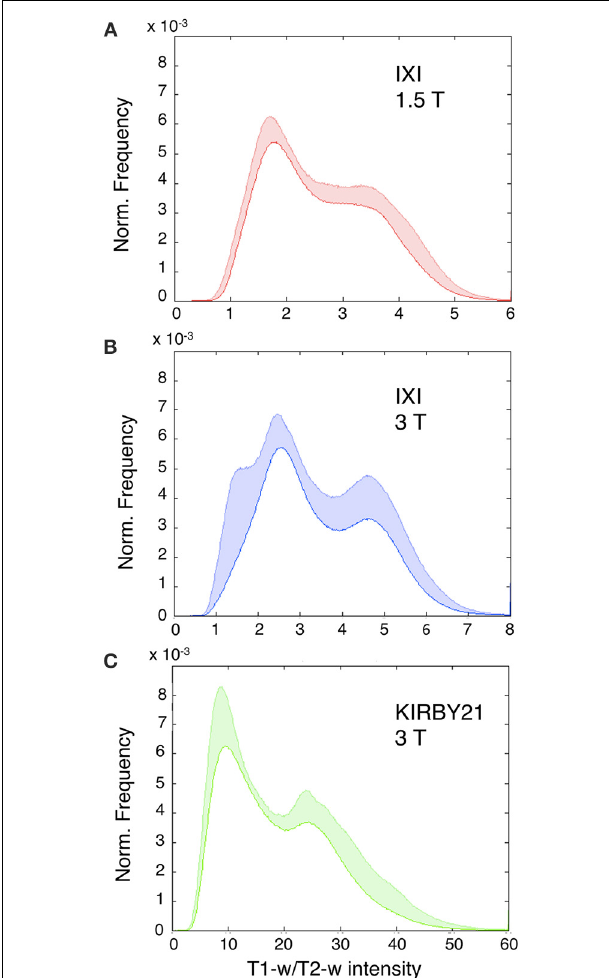
FIGURE 5 | Histograms of T1-w/T2-w image intensities before calibration. Mean T1-w/T2-w histograms (with standard deviation in colored shade) are presented for the IXI 1.5 T (A) , IXI 3 T (B) , and KIRBY21 3 T (C) datasets. The three datasets have inconsistent T1-w/T2-w intensity values. (A) IXI 1.5 T dataset shows a relatively large inter-subject reproducibility with the smallest extent of standard deviation. (B) IXI 3 T dataset displays a similar trend with an increased standard deviation in correspondence to the gray matter peak. (C) KIRBY21 3 T dataset exhibits the greatest inter-subject variability especially in the right tail of the